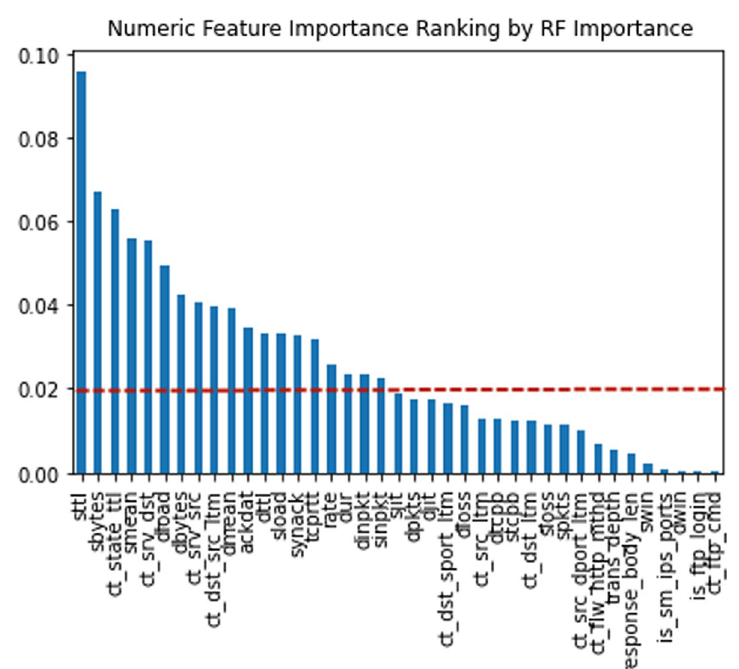
Fig. 9 Numeric feature importance ranking by random forest